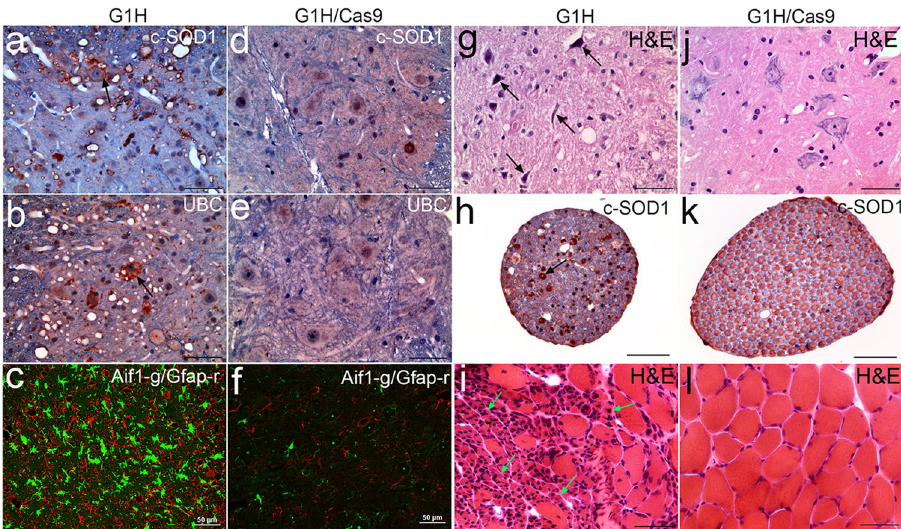
Fig. 2 ALS-free pathology in G1H/Cas9 mice. The spinal cord sections were stained and analyzed using immunohistochemistry ( a , b , d , e ) or confocal microscopy ( c , f ) using the indicated antibodies. Representative images from an end stage G1H (#3702, 148 days) and hSOD1 -targetd G1H/Cas9 mice (#7450, 196 days) are shown. Immunoreactive aggregates are indicated by arrows ( a , b ). c , f Microglial activation and astrocytosis are shown by Aif1 (green) and Gfap (red) staining, respectively. g , j H&E staining of the spinal cord sections showing motor neuron shrinkage (arrows) in the anterior horn of G1H mice. h , k Loss of large-caliber axons in an anterior root in G1H mice. Arrow indicates SOD1 aggregates in a motor axon. i , l H&E staining of the gastrocnemius muscles showing muscle fi ber atrophy (green arrows) in the G1H mice. Scale bar, 50 µ m. These pathological changes are absent in the G1H/Cas9 mice.